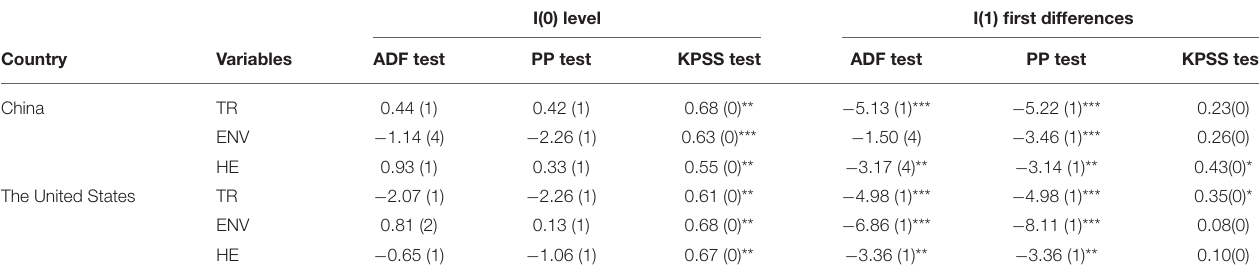
TABLE 2 | Results of the unit root test.